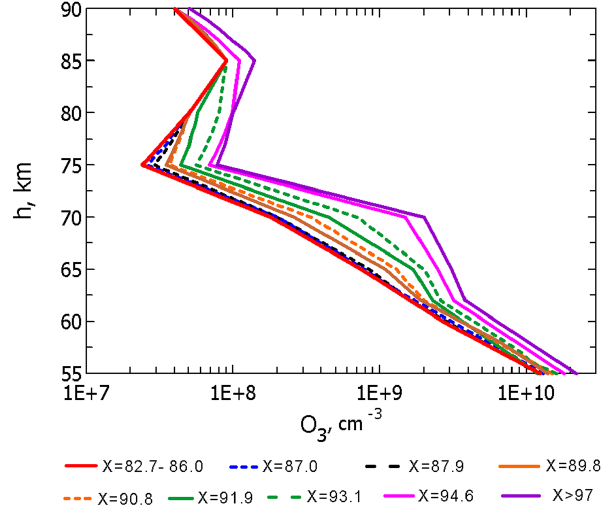
Fig. 11. Height profiles of the O 3 concentration as a function of the solar zenith angle. The O 3 -profile 4 (local noon and χ< 86 ◦ ) is shown by the red